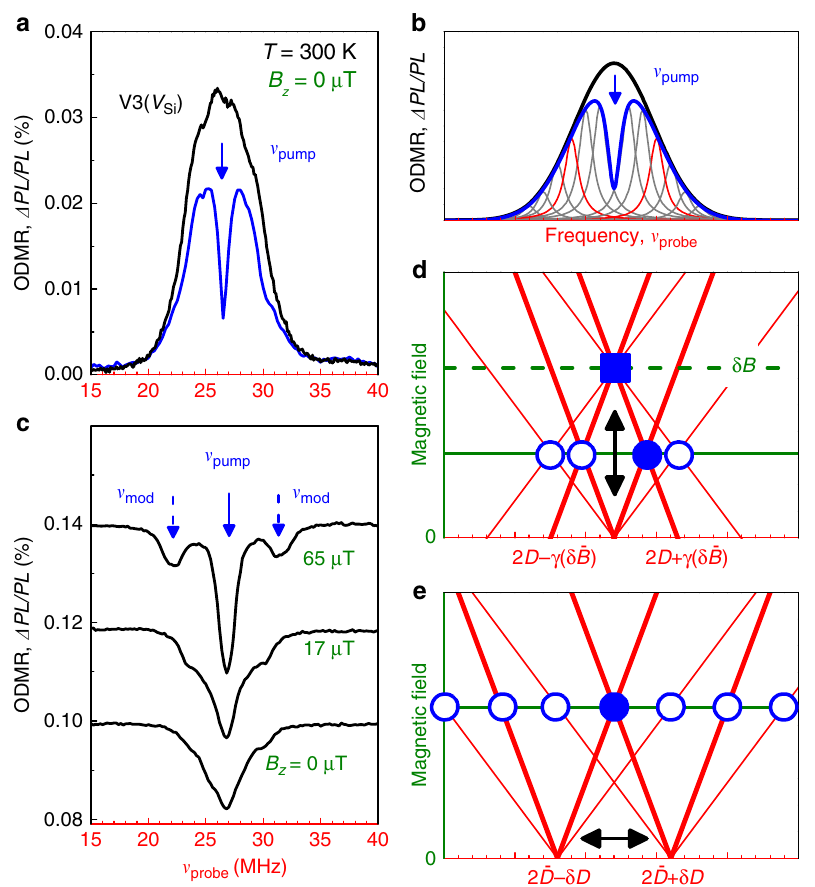
Fig. 1 Two-frequency ODMR spectroscopy. a ODMR spectrum of isotopically puri fi ed 6H-SiC without and with the pump MW fi eld at v pump = 26.8 MHz. The pump and probe powers are W probe = 7 dBm and W pump = 14 dBm, respectively. b A schematic modeling of ( a ) by subtraction the contribution of a homogeneously broadened spin packet from the Gauss-shaped ODMR line. c Pump-induced changes in the ODMR spectra in different magnetic fi elds. The dashed arrows indicate the qudit mode frequencies. d , e The fan charts of the qudit modes as a function of the magnetic fi eld in case when the inhomogeneous broadening is caused by magnetic fl uctuations and variation for the zero- fi eld splitting, respectively. The solid symbols correspond to the pump frequencies and the open circles correspond to the excited qudit mode frequencies. The red lines of the fan charts indicate the spectrally selected spin